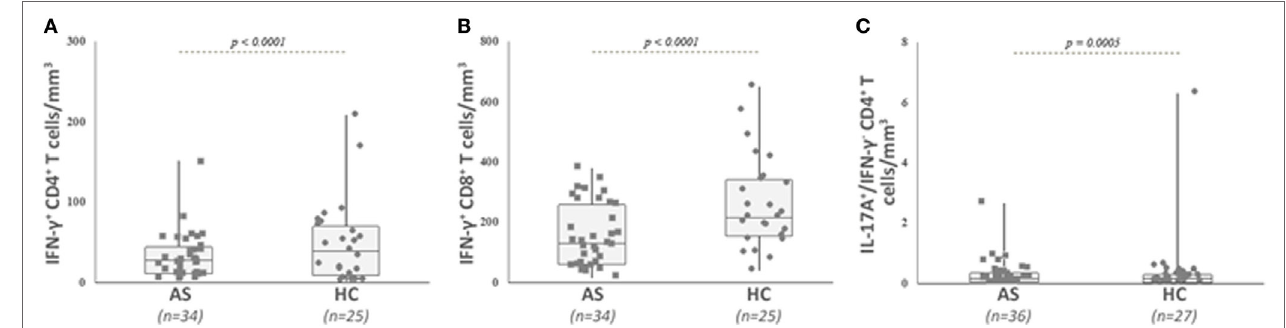
FigUre 3 | Analysis of IFN- γ secreting conventional CD4 + and CD8 + T cells, as well as IL-17A- and IFN- γ -producing CD4 + T cells in patients with ankylosing spondylitis (AS) and healthy controls (HC). Circulating cytokine-secreting conventional T cells were analyzed as described in Section “Patients and Methods” and gated as described in Figure 2 . Absolute numbers (cells/mm 3 ) were obtained by multiplying the percentages of these T cells by the total T lymphocyte number. AS patients exhibited a significant lower number of IFN- γ secreting conventional CD4 + T cells (a) , IFN- γ secreting conventional CD8 + T cells (B) , and IL-17A positive IFN- γ negative CD4 + T cells (c) than HC. Data are depicted as box plots (the band inside the box corresponds to the median). Each symbol represents an AS patient (squares, n = 34 or 36) or HC (circles, n = 25 or 27).